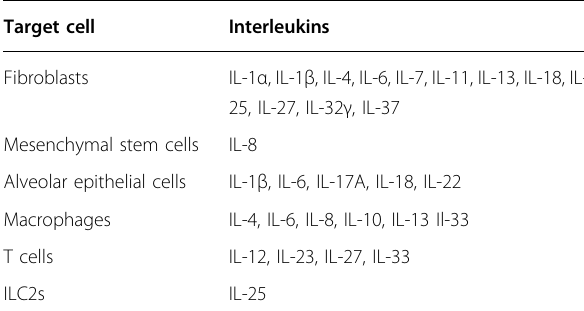
Table 3 Target cells of interleukins in pulmonary fi